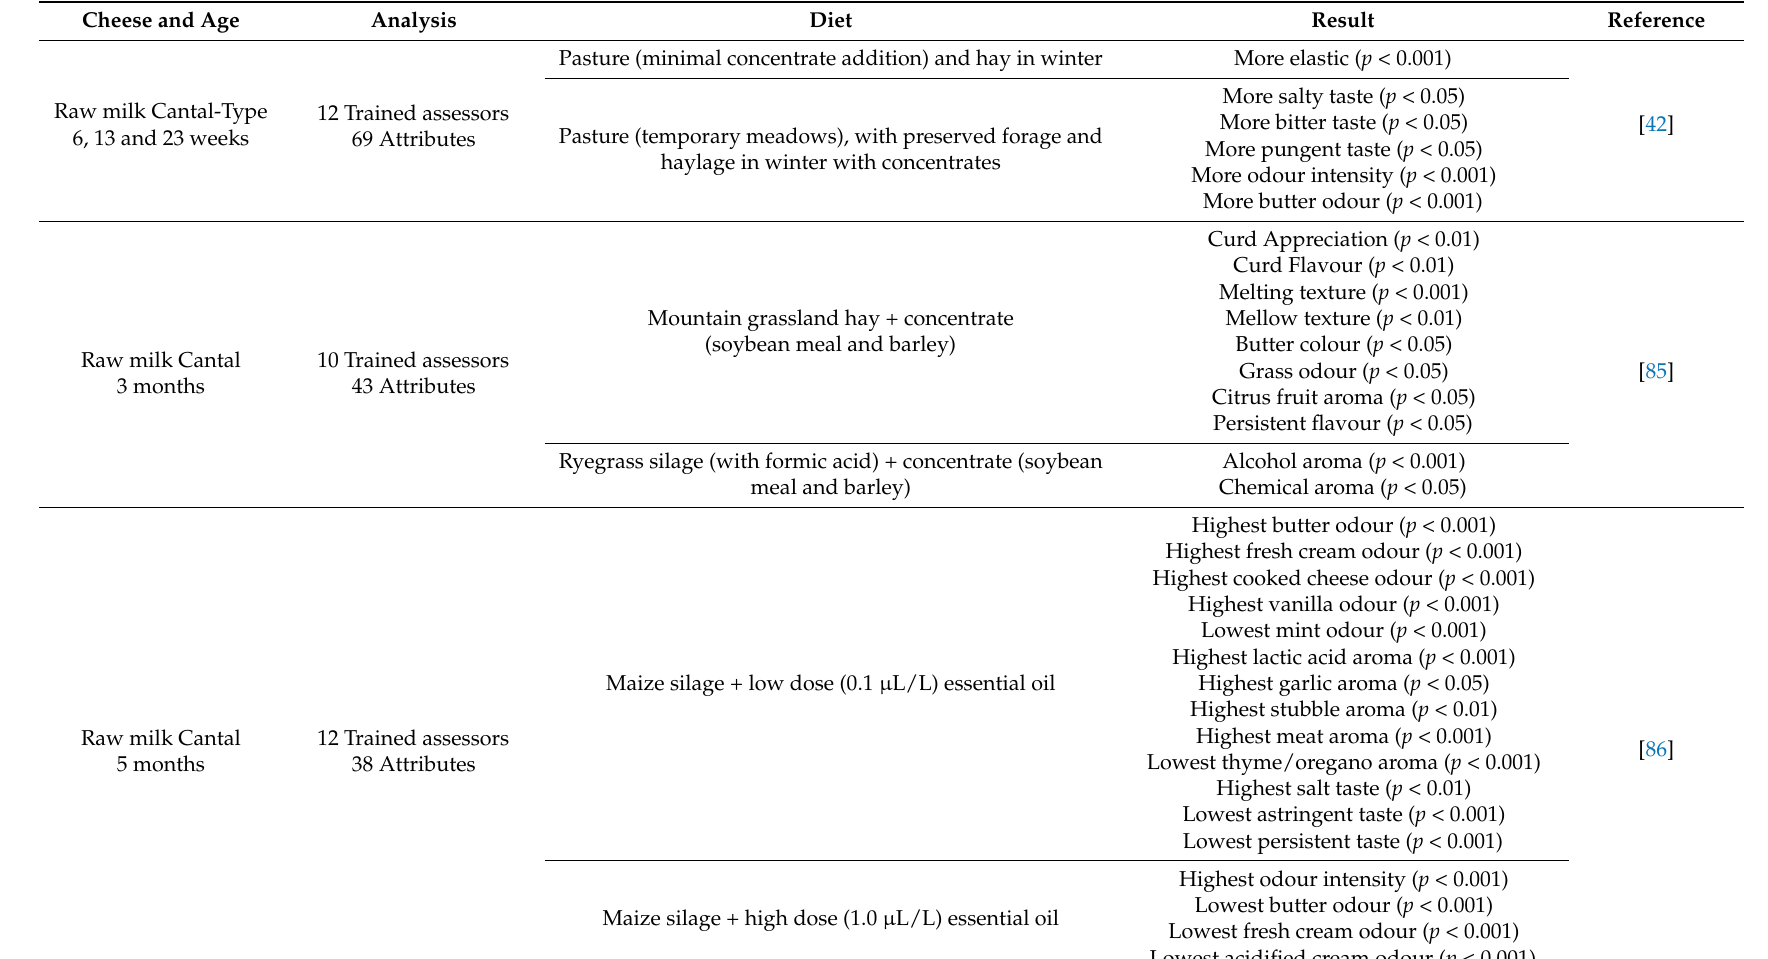
Table 4. Summary of descriptive sensory analysis studies bovine